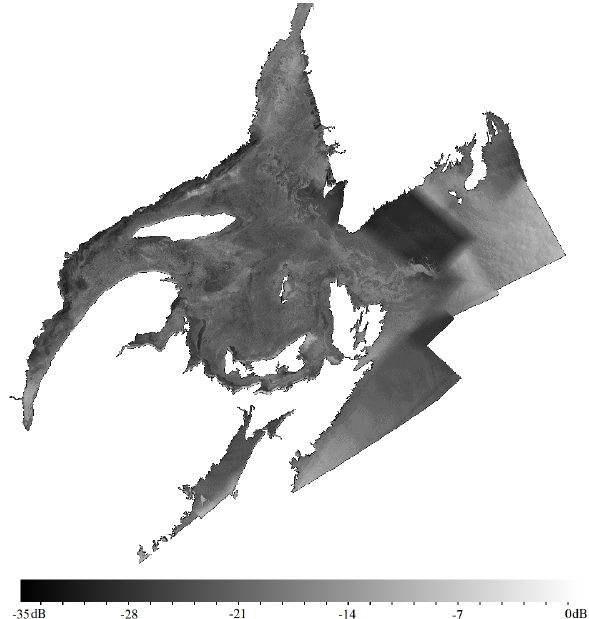
Fig. 6. An example of a SAR mosaic (based on RADARSAT-2 data,© MDA), on 5 March 2009, the boundaries between SAR frames have been smoothed in the mosaic. The white areas are either land or sea areas not covered by the SAR data. The scale in dB is shown by the colorbar.